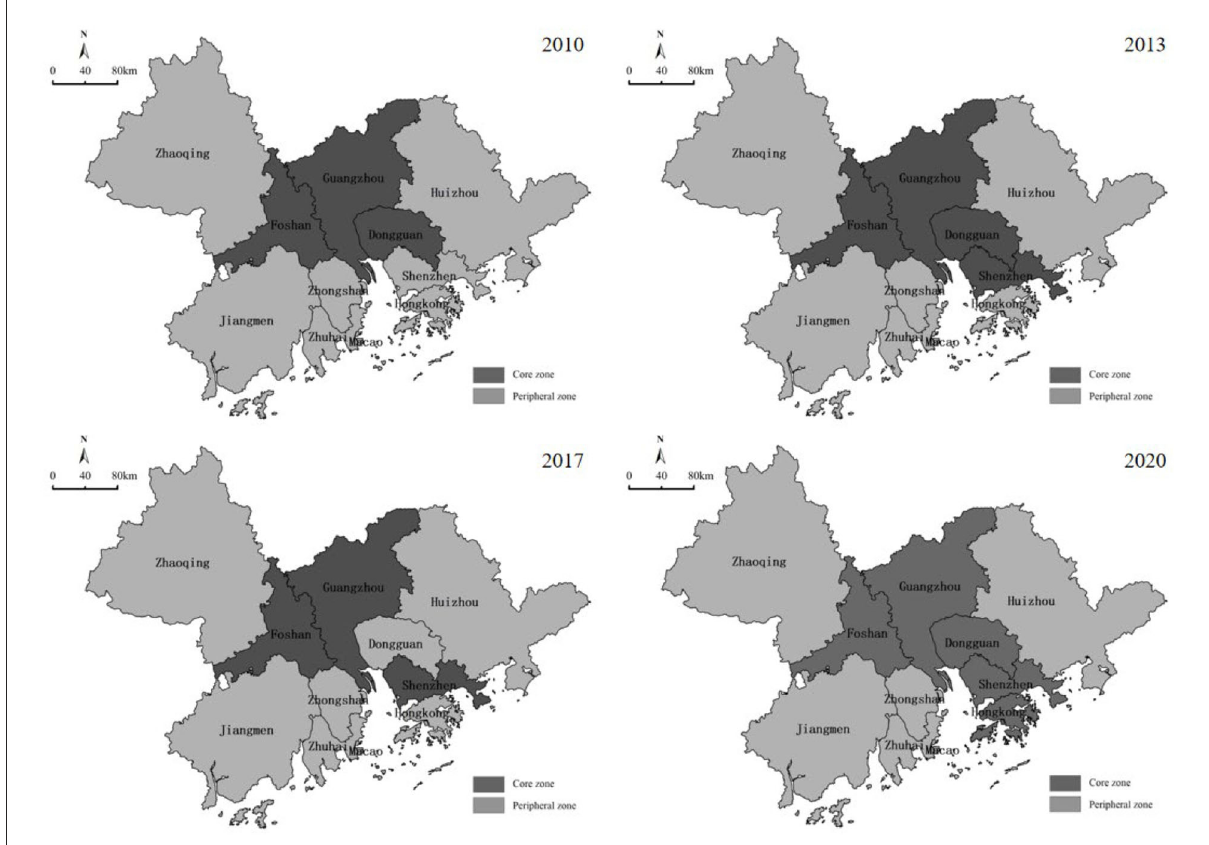
FIGURE9 Core-periphery analysis of the